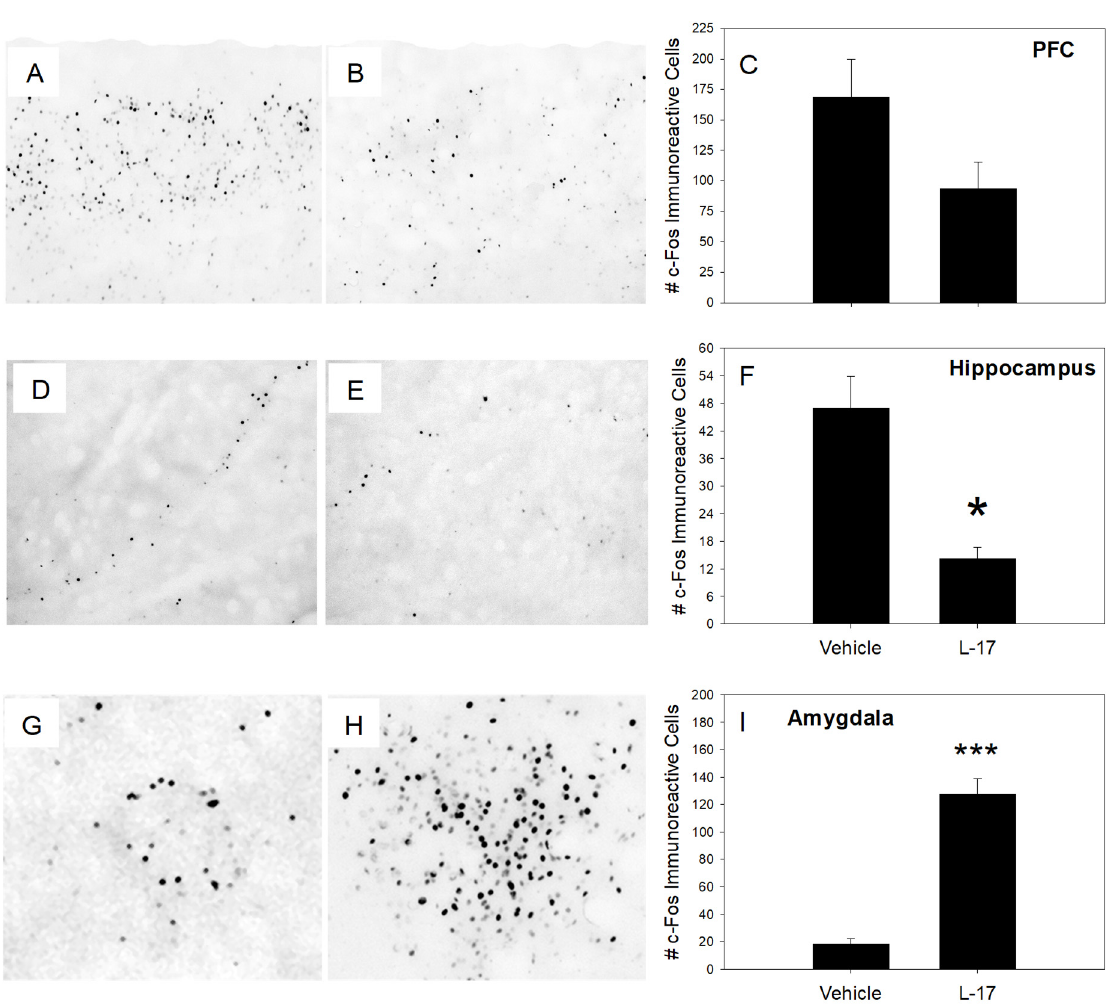
Figure 4. Representative sections illustrating the expression and distribution of c- Fos protein immunolabeled cells in the prefrontal cortex PFC, ( A–C ), hippocampus ( D–F ), and the central nucleus of the amygdala ( G–I ) in vehicle- and L-17-pretreated rats. * p < 0.05 and *** p < 0.001, two-tailed Student’s t -test.